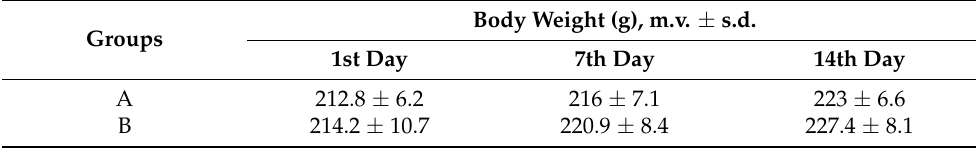
Table 5. Change in body weight as a function of days following oral drug administration.